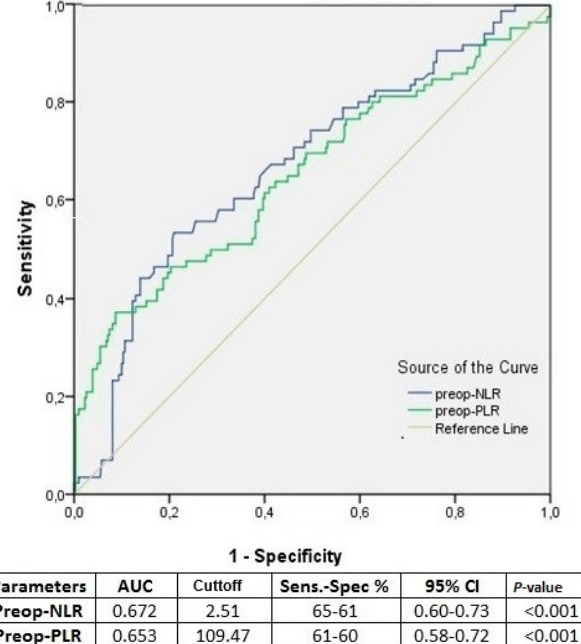
Fig. 1 - Receiver operating curve analysis for preoperative (preop.) neutrophil-lymphocyte ratio (NLR), delta-NLR, and platelet- lymphocyte ratio (PLR) values regarding occurrence of postoperative acute kidney injury during hospital stay. AUC=area under the curve; CI=confidence interval;